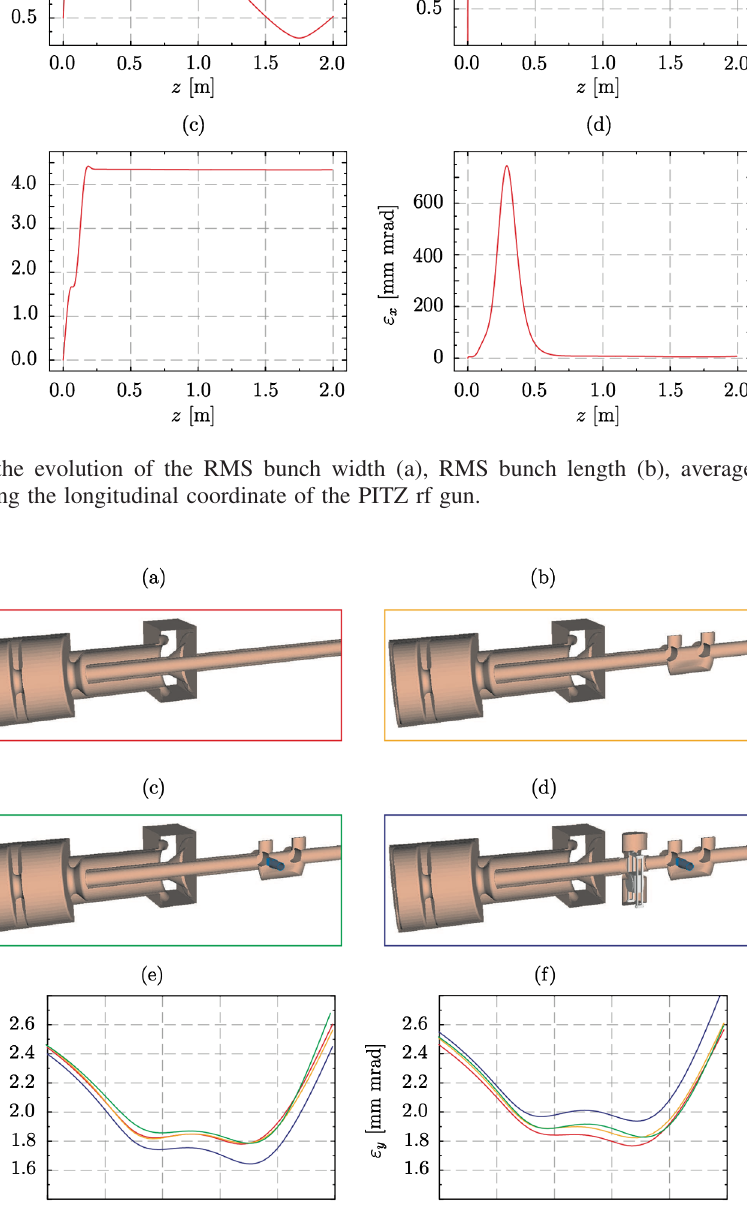
and " are similar for case (a), they show a distinct asymmetry for the x y